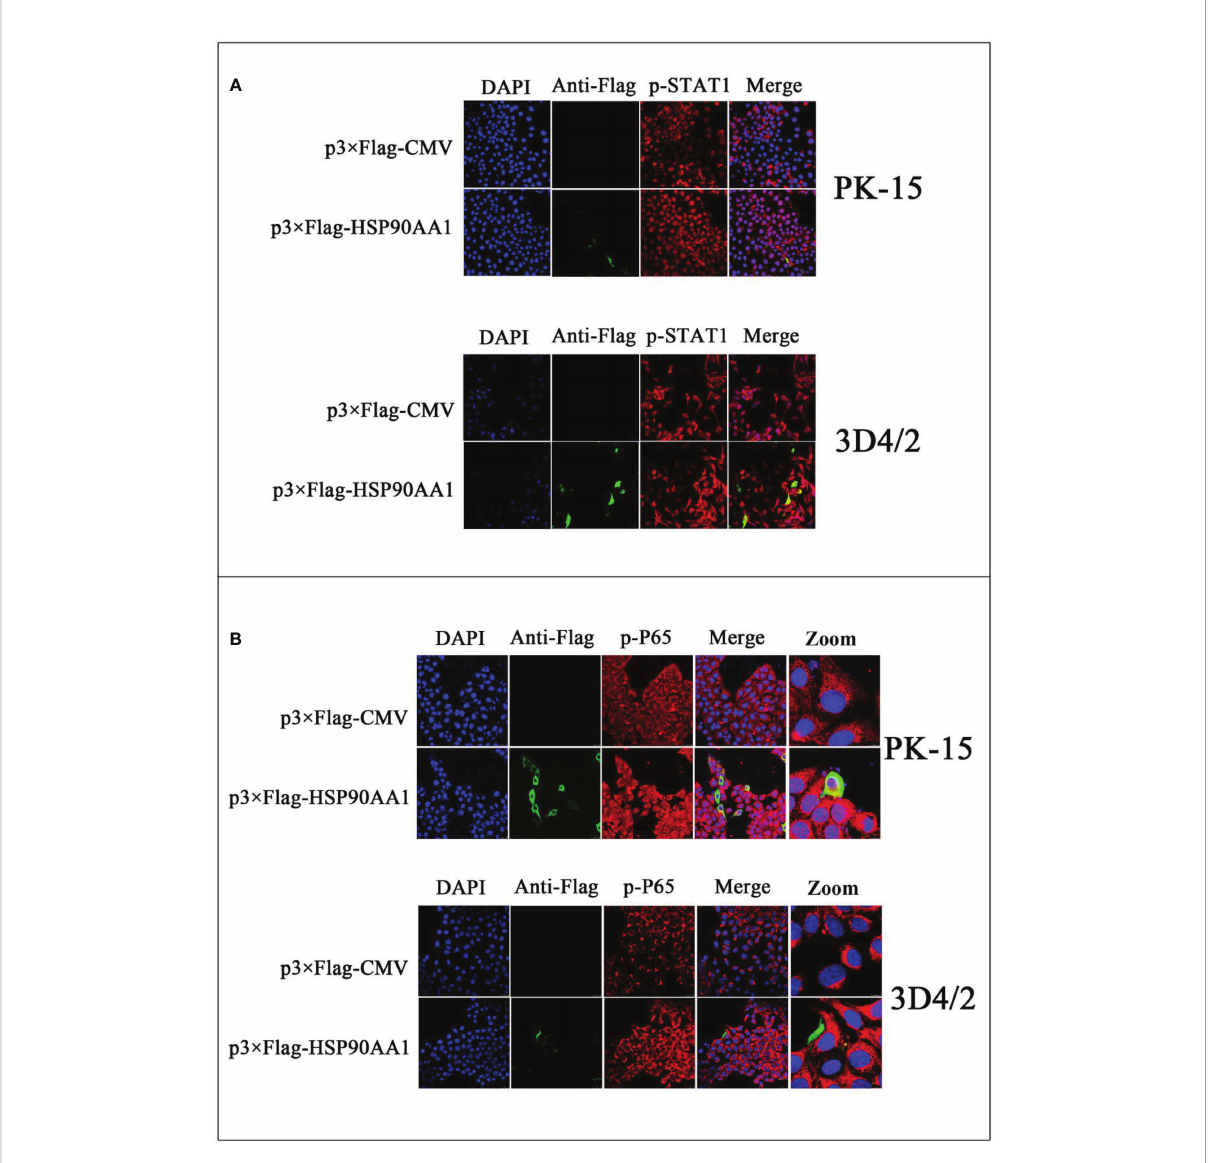
FIGURE 6 HSP90AA1 over-expression activates STAT1 and P65 in PK-15 and 3D4/2 cells. (A) HSP90AA1 over-expression affected the phosphorylation of STAT1 and nuclear translocation of p-STAT1 in PK-15 and 3D4/2 cells were observed by laser confocal microscopy. (B) HSP90AA1 over- expression affected the nuclear translocation of p-P65 in PK-15 and 3D4/2 cells were observed by laser confocal